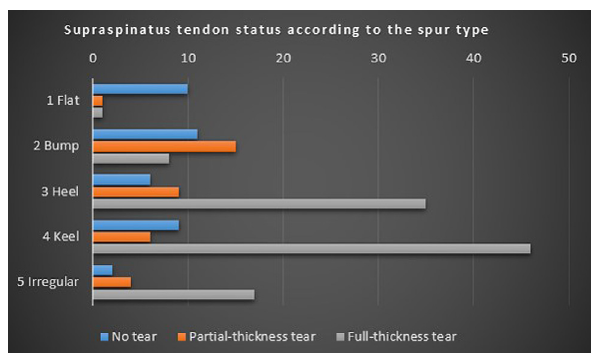
Figure 3. The prevalence of the supraspinatus tendon tear along the morphological